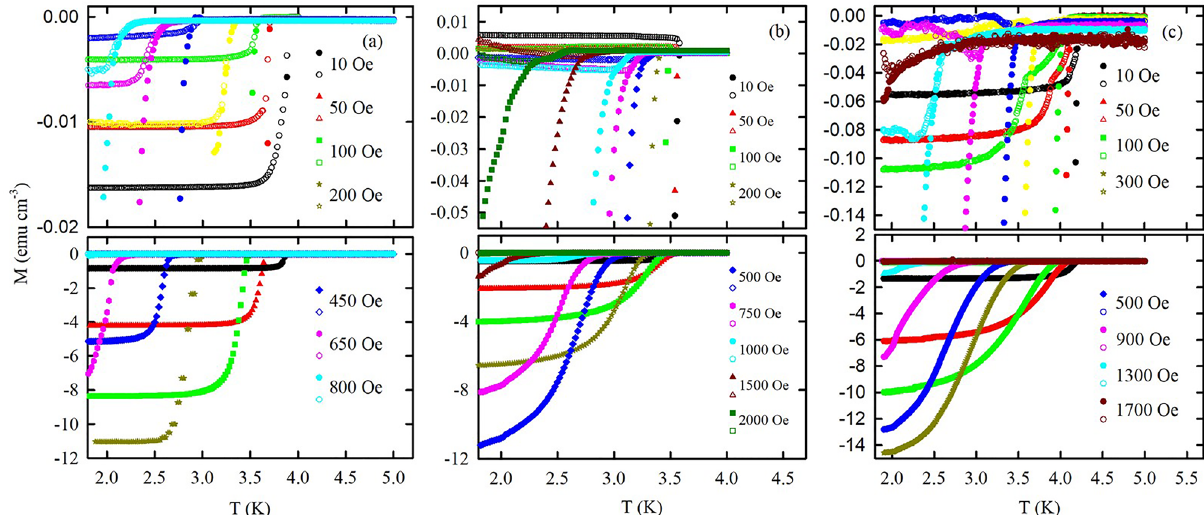
Figure 2. Temperature dependences of dc magnetization under ZFC (closed symbols) and FC (open symbols) protocols at different external magnetic fields. The upper panels show magnetization in a larger scale for better